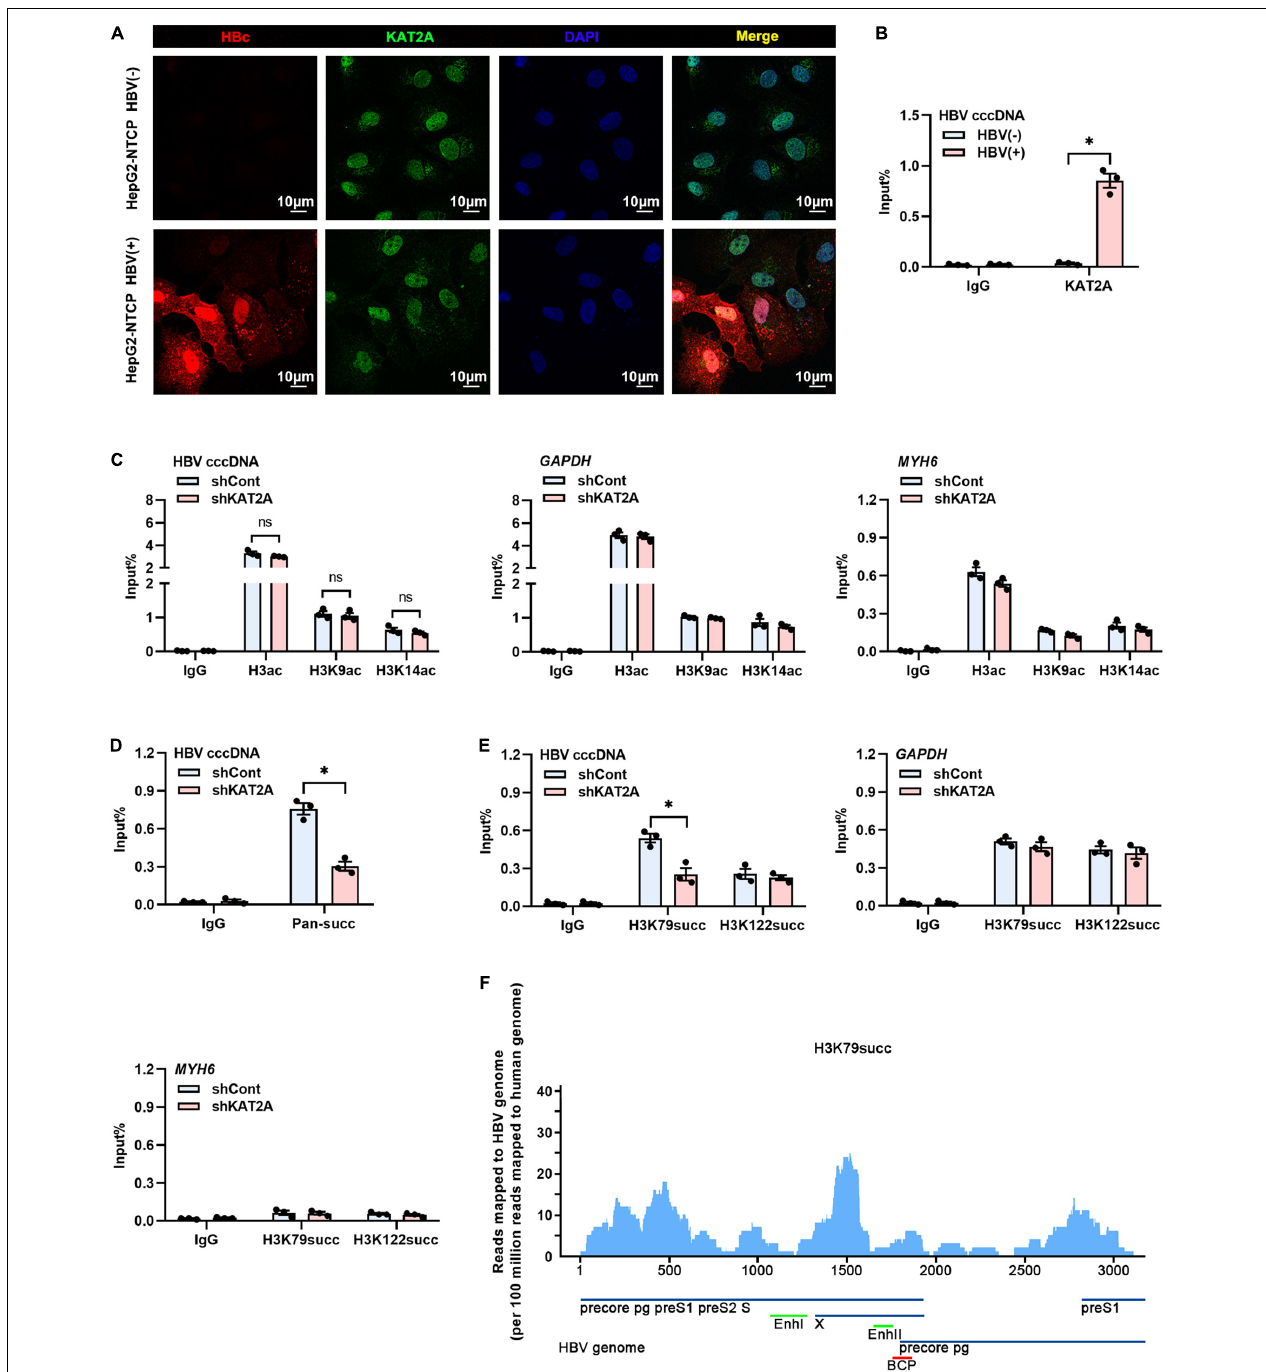
FIGURE 4 | KAT2A bound to cccDNA and regulated H3K79 succinylation on the cccDNA minichromosome. (A) HepG2-NTCP cells were infected with HBV particles for 4 days, HBV core protein and endogenous KAT2A were observed by immunofluorescence assay using the specific antibodies. The scale bar is 10 µ m. (B) Cross-linked chromatin from the HBV-infected and non-infected HepG2-NTCP nucleus was immunoprecipitated with a specific antibody or the control lgG. Taq-man probe qPCR was used to detect the HBV cccDNA level. ChIP results are expressed as% of input. (C–E) HepG2-NTCP cells were infected with HBV particles at 1-day post shKAT2A transduction. On 4 days post-infection. (C) The levels of H3ac, H3K9ac, and H3K14ac associated with cccDNA, GAPDH, or MYH6 promoter were analysed by ChIP assay with anti-H3ac, anti-H3K9ac, anti-H3K14ac, and the corresponding IgG, respectively. (D) ChIP assay was performed with anti-Pan-succ antibody. (E) The levels of H3K79succ and H3K122succ associated with cccDNA, GAPDH, or MYH6 promoter were analysed by ChIP assay with anti-H3K79succ, anti-H3K122succ, and the corresponding lgG, respectively. (F) ChIP-Seq analysis of the H3K79succ modification on the cccDNA minichromosome. The HBV-specific reads were quantified and normalised by the reads mapped to the human genome. * P < 0.05.